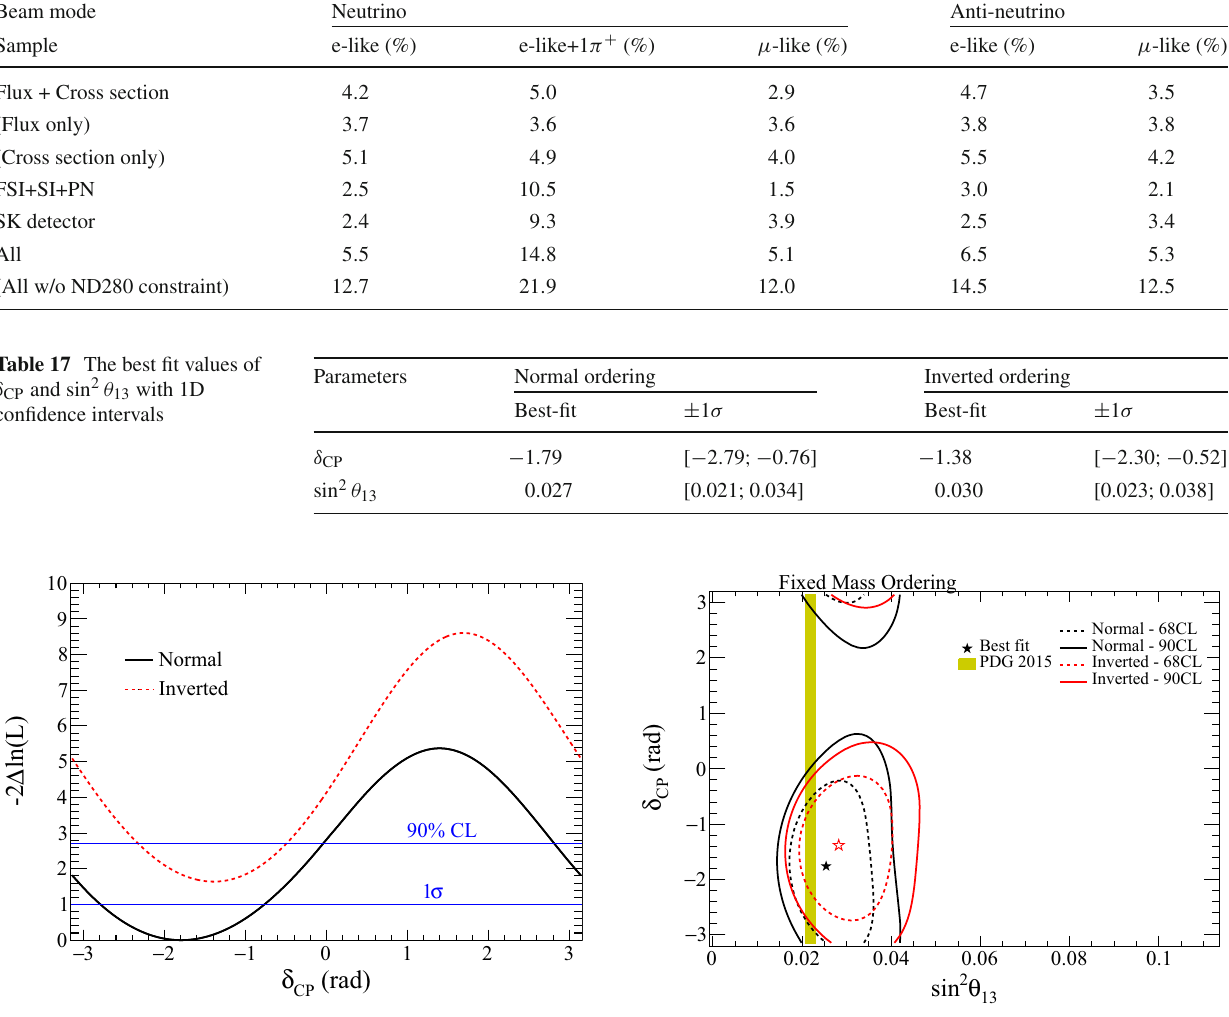
one-dimensional posterior probability densities. The poste- rior probabilities for the mass orderings and sin 2 θ 23 octant are also evaluated as shown in Table 19. The results slightly prefer the normal mass ordering with sin 2 θ 23 > 0 .